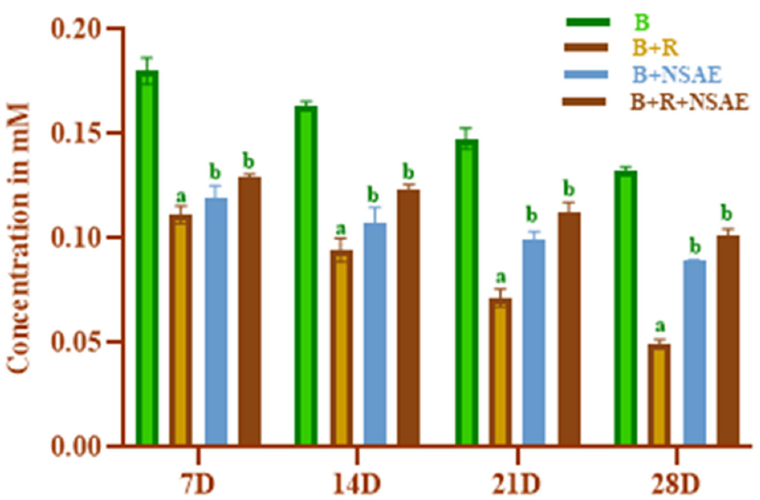
Figure 7. The effect of NSAE on thiol group formation in BSA+D-ribose system. B-BSA, B+R=BSA+Ribose, B+NSAE=BSA+ Nigella sativa aqueous extract, and B+R+NSAE= BSA+Ribose+ Nigella sativa aqueous extract. Results are represented as mean ± SD ( n = 5). a p < 0.05 when compared to BSA and b p < 0.05 when compared to BSA+D-ribose.